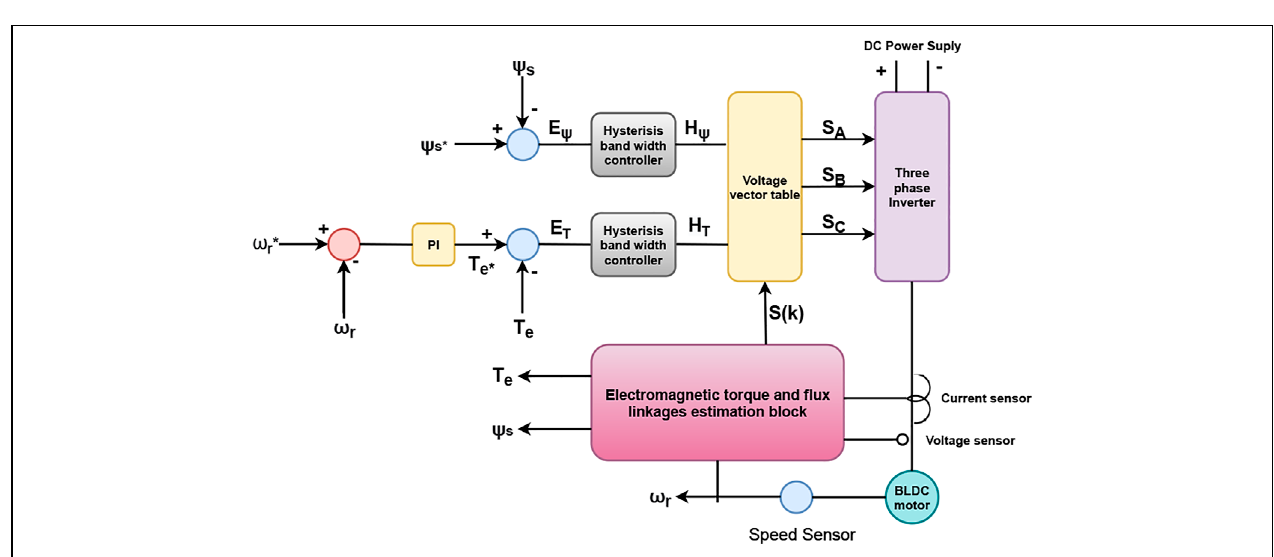
FIGURE 5 | Block diagram of direct torque control and flux control (Bose